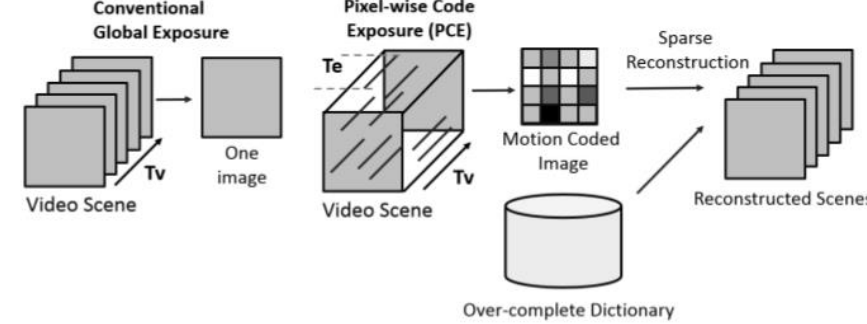
Figure 1. Conventional camera (left) vs. pixel-wise code exposure (PCE) camera (right) [9]. The coded aperture